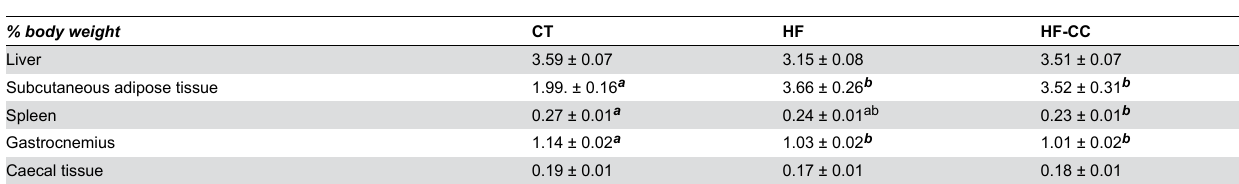
Table 1. Weight of tissue.